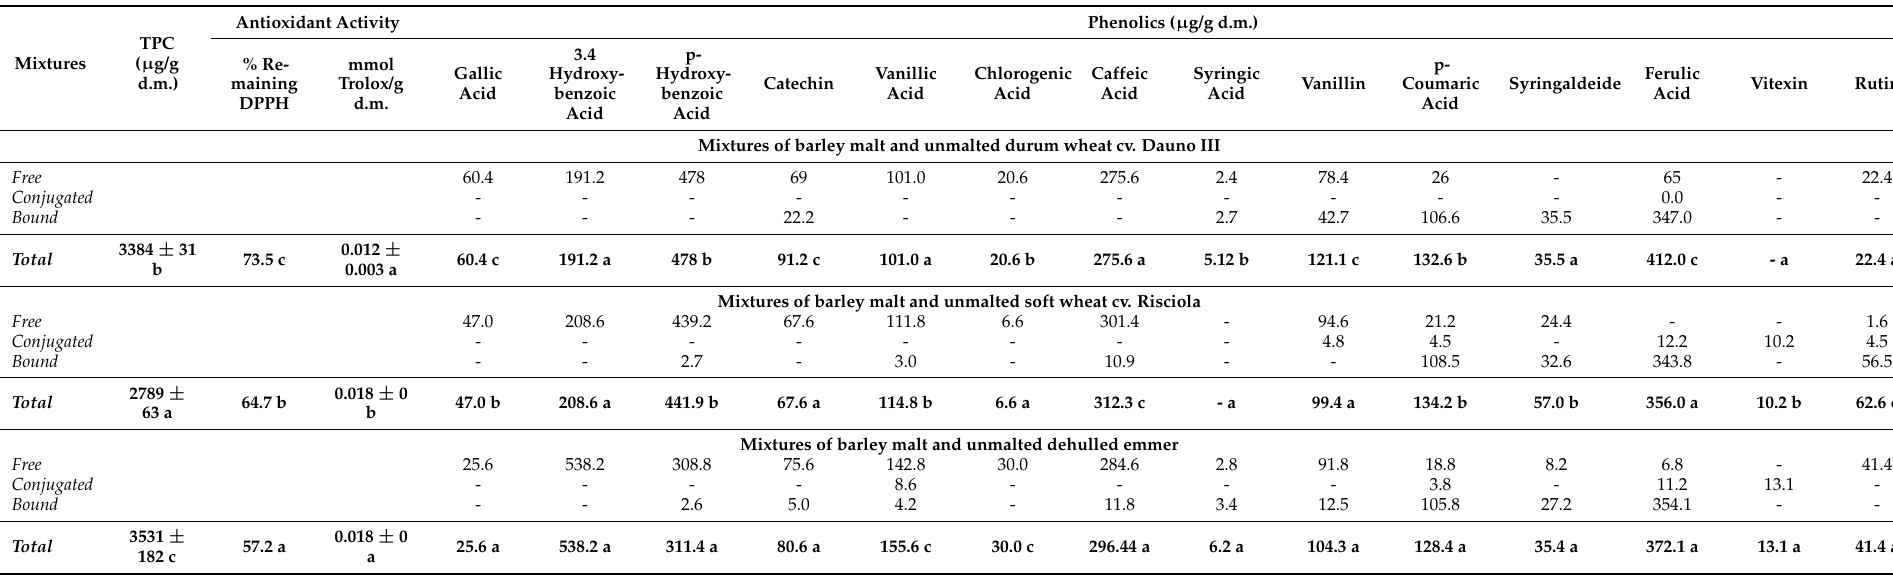
Table 2. Total phenolic content, antioxidant activity, and phenolic profile of the 3 binary mixtures made of 60% barley malt and 40% unmalted